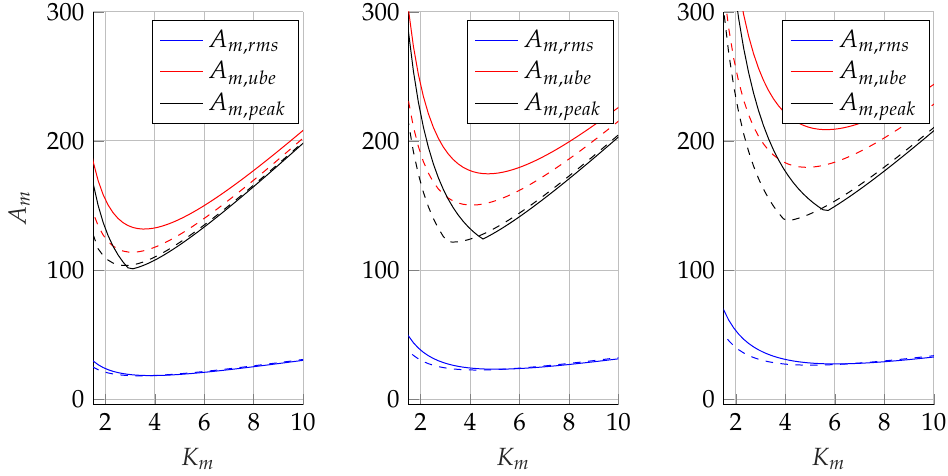
Figure 15. Load curves sensitivity analysis for axis 2 at different payloads (from left to right 0, 2 and 4 kg). Using the same color coding, the dashed lines represent an exclusively dynamic loading condition, while the continuous lines take into account also the static